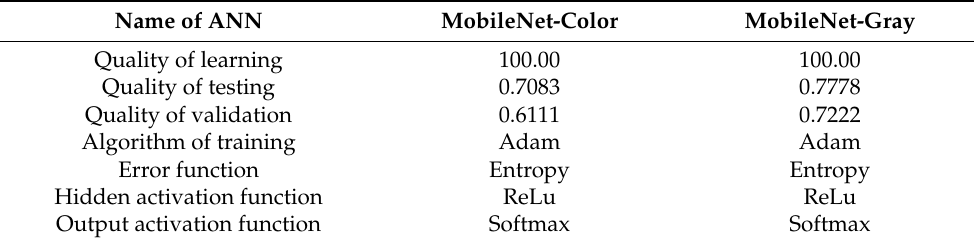
Table 3. Learning results of MobileNettype artificial neural networks against images expressed in RGB or greyscale